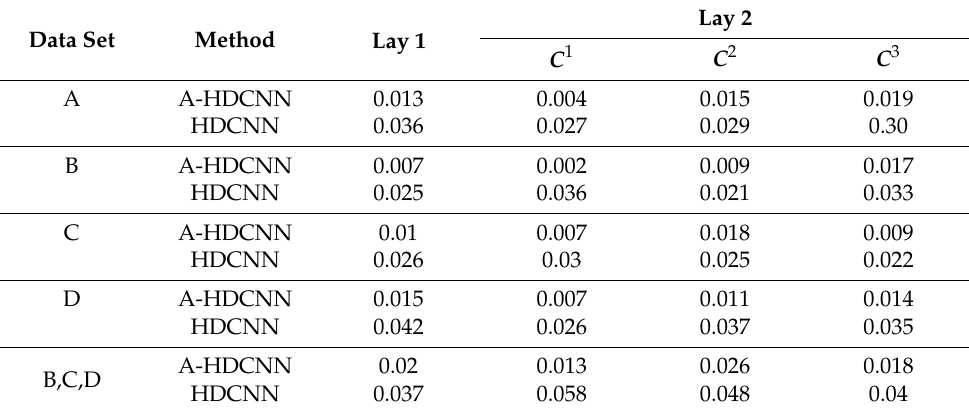
Table 6. Comparison of model error loss between A-HDCNN and HDCNN under different load